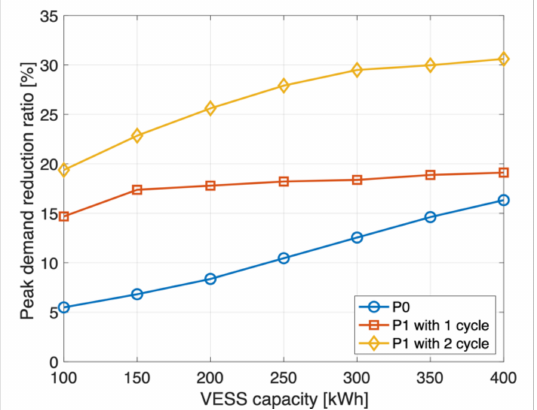
Figure 5. Peak demand reduction ratio with varying implemented VESS